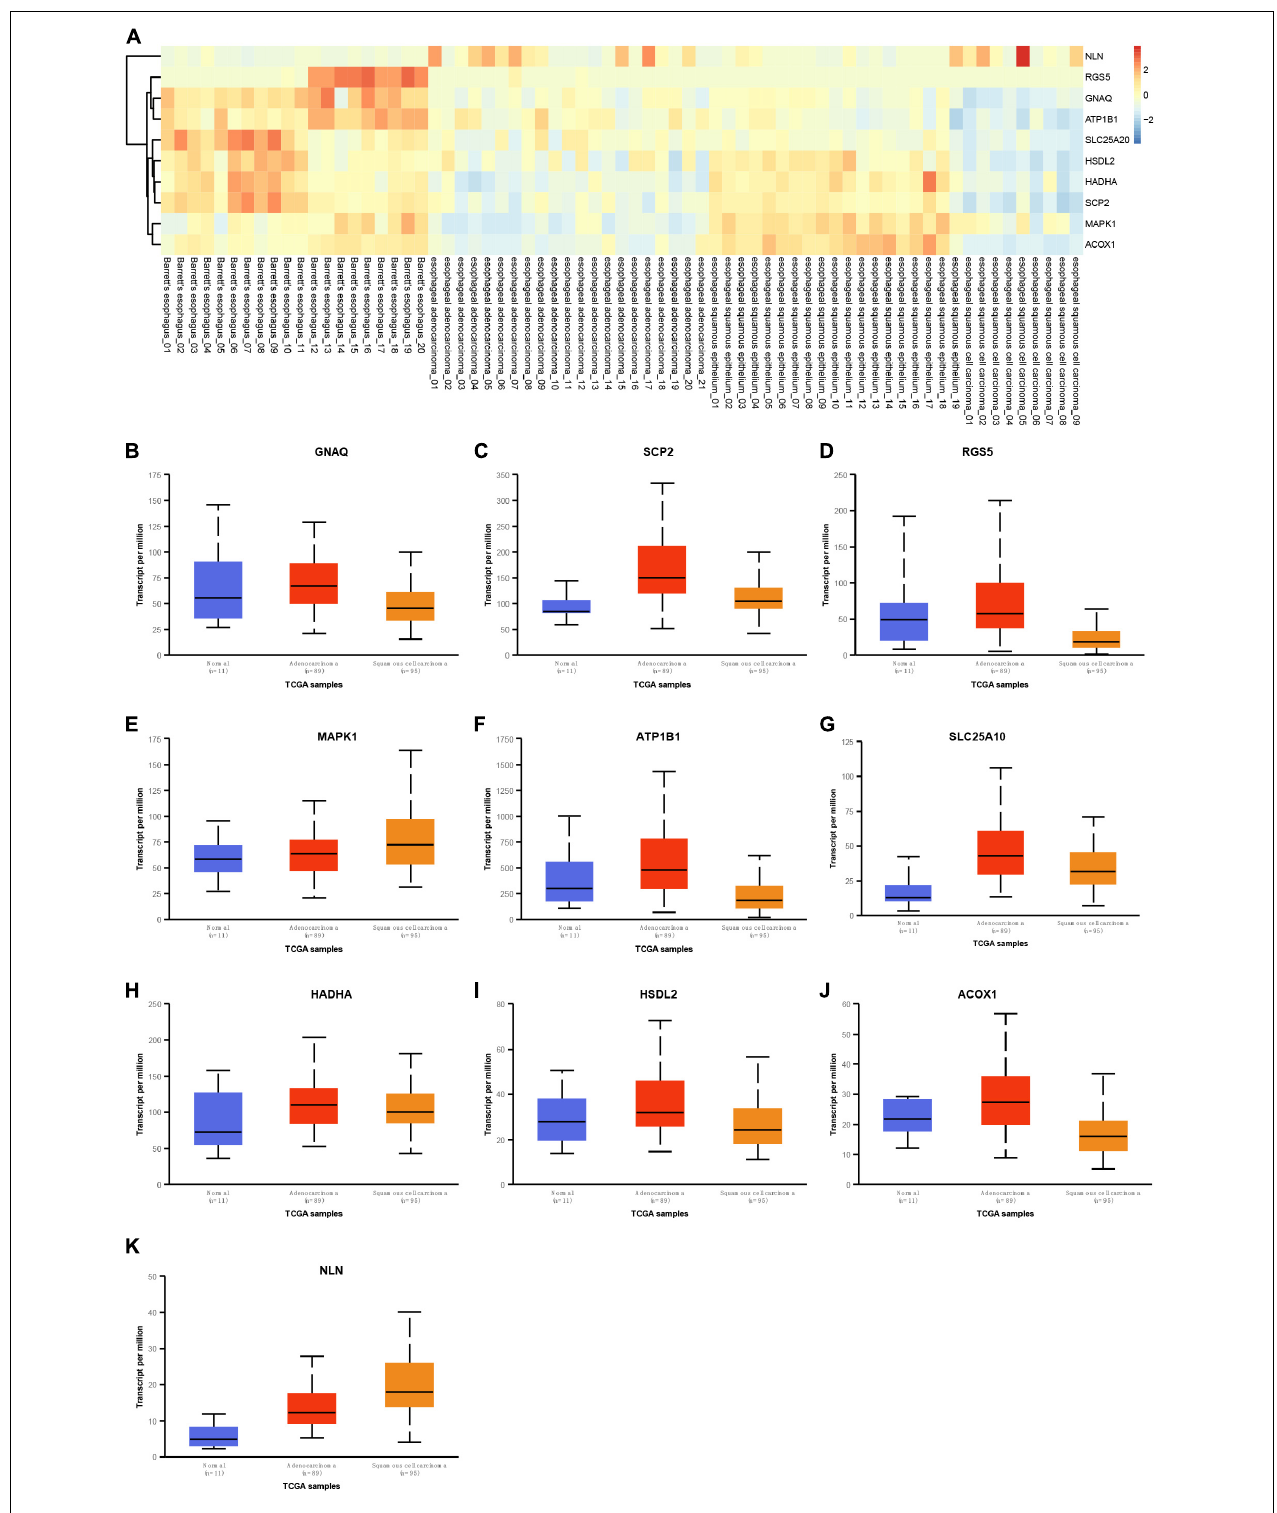
FIGURE 8 | Validation of hub genes expression in esophageal adenocarcinoma (EA) and esophageal squamous cell carcinoma (ESCC). (A) GNAQ, RGS5, MAPK1, ATP1B1, HADHA, HSDL2, SLC25A20, ACOX1, and SCP2 were reduced in esophageal cancer (EC) samples, and NLN was significantly induced in EC samples compared to normal tissues by analyzing GSE26886. (B–K) GNAQ (B) , SCP2 (C) , RGS5 (D) , MAPK1 (E) , ATP1B1 (F) , HADHA (G) , HSDL2 (H) , ACOX1 (I) , SLC25A20 (J) , and NLN (K) were differently expressed in EA and ESCC samples compared to normal tissues by analyzing UALCAN database.